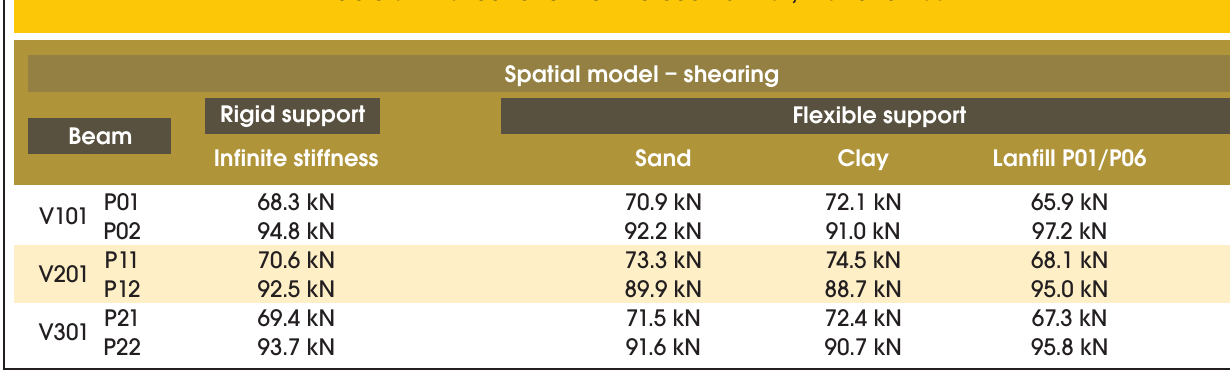
Table 5.7 – Shear effort for the beams V101,V201 and